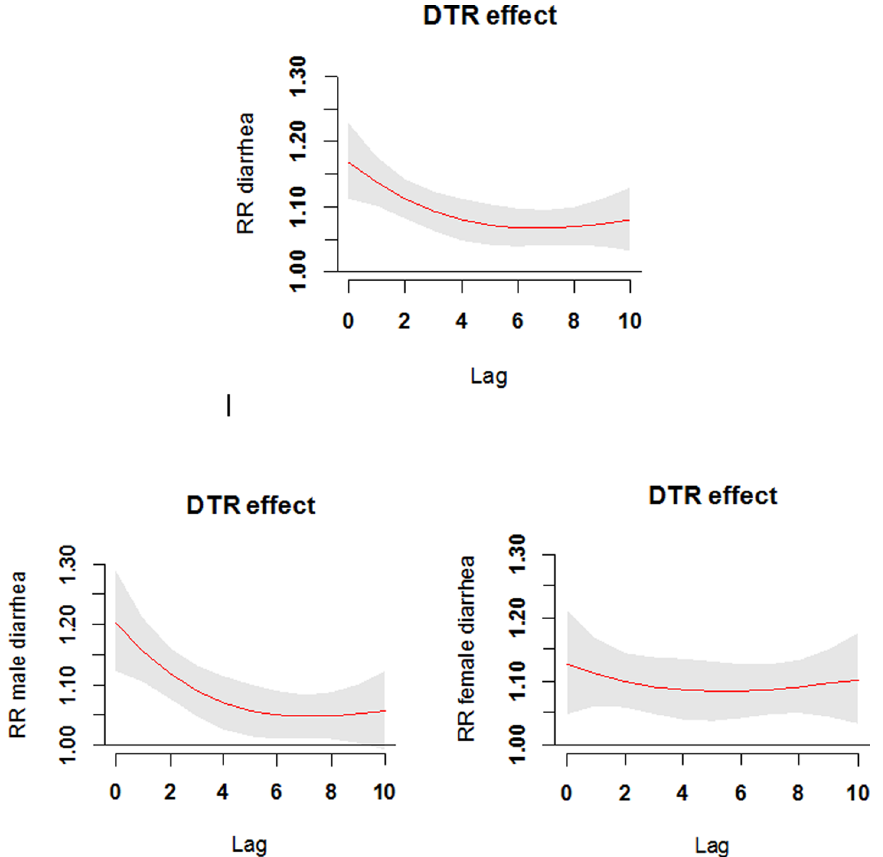
Figure 3. The lagged effects of diurnal temperature range on diarrhea among children under five years.